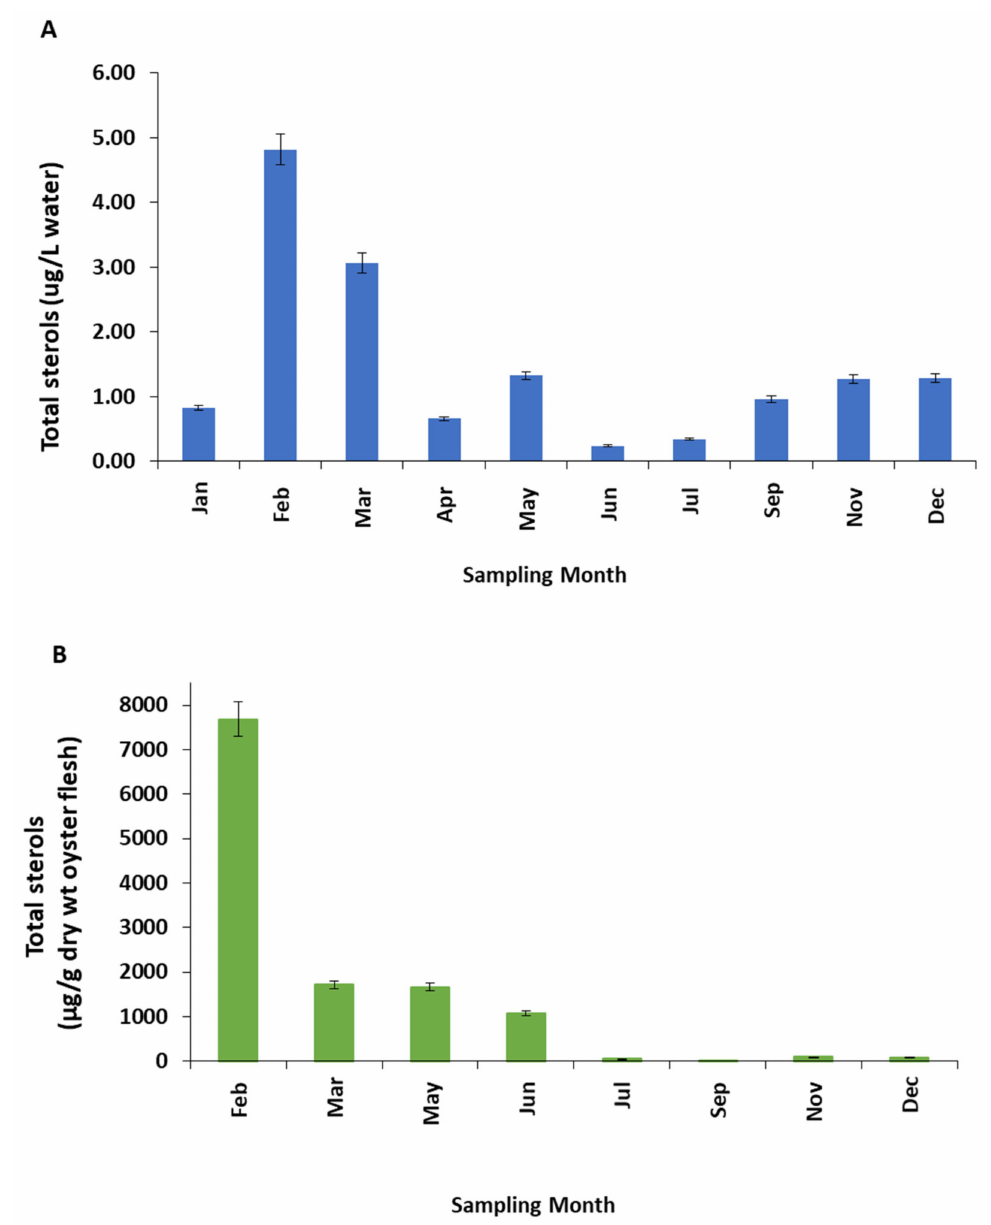
Figure 2. Total sterol content in ( A ) water ( µ g L − 1 ) collected from the oyster beds (Site 4), and ( B ) ( µ g g − 1 oyster flesh) over a 12-month period (mean ± standard error). Due to adverse weather conditions, no oysters were collected in January, April, August or October; no water samples were collected in August and